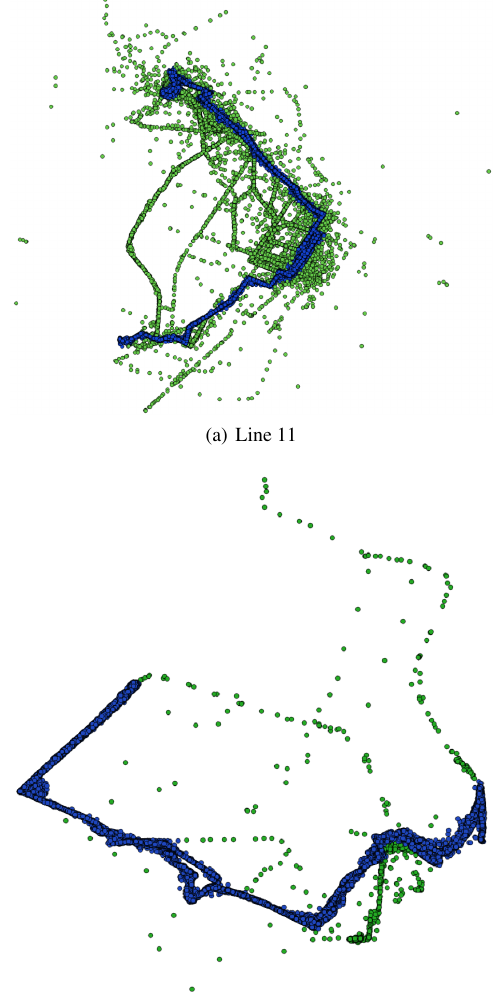
Figure 2. Case studies for two bus lines in Turin (Italy, April 2017): blue dots are the positions actually recorded along the regular bus line path, green dots are the outliers.